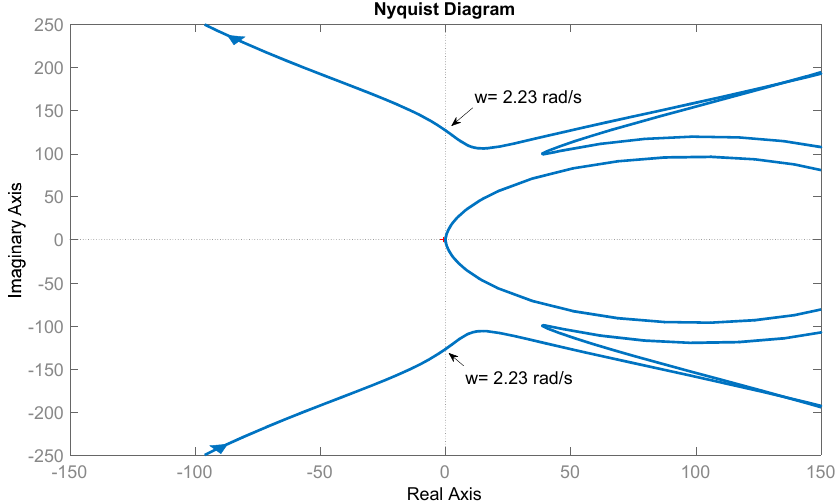
Figure 6. Detailed zoom of Nyquist plot of the second order transfer function.